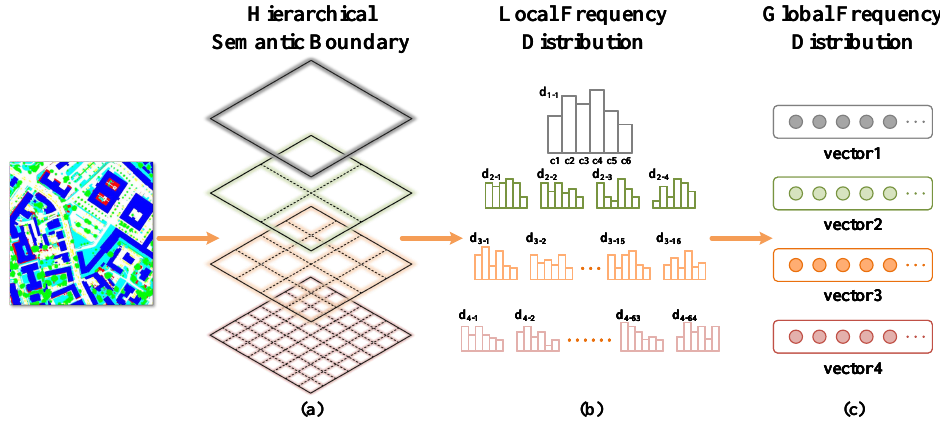
Figure 5. Schematic diagram of the HSE vector calculation process with 4 levels. ( a ) Boundaries in different colors indicate different segmentation scales. ( b ) Simplified diagram of the local frequency distribution. ( c ) Visual presentation of the HSE